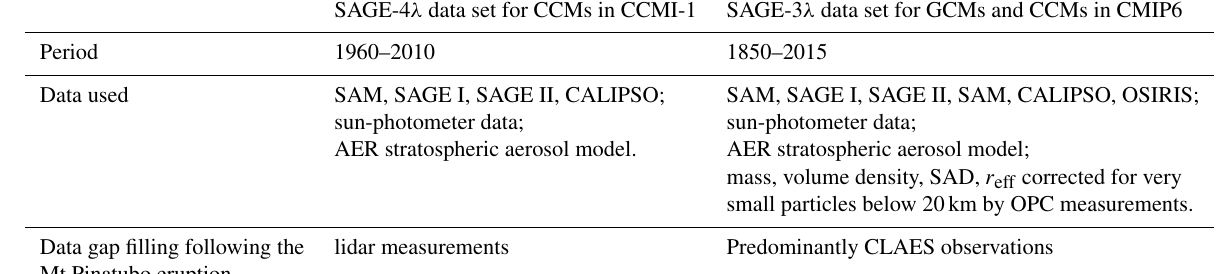
Table 1. Stratospheric aerosol data sets used for CCMI-1 and CMIP6. SAGE-4 λ data set for CCMs in